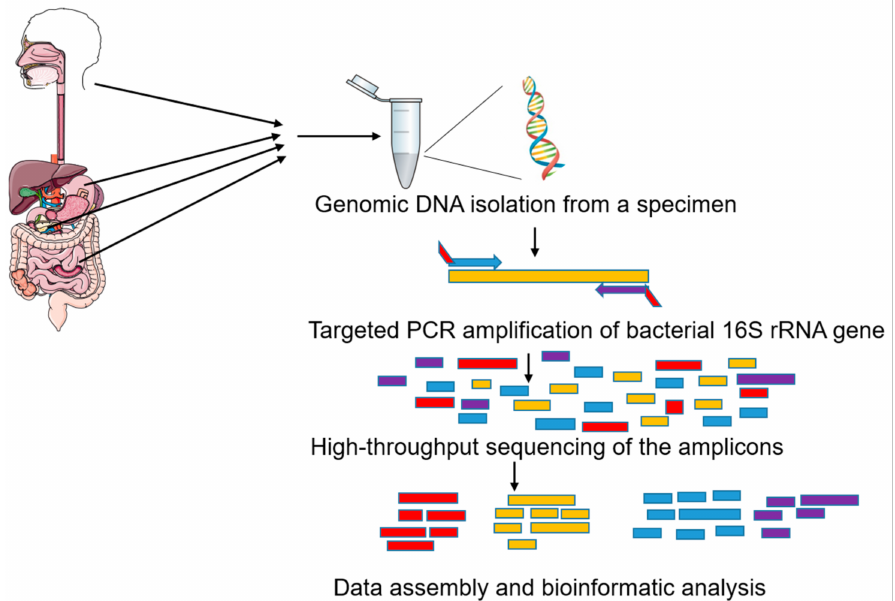
Figure 2. Workflow for identification of microbiota in a specimen by targeted 16S rRNA amplicon